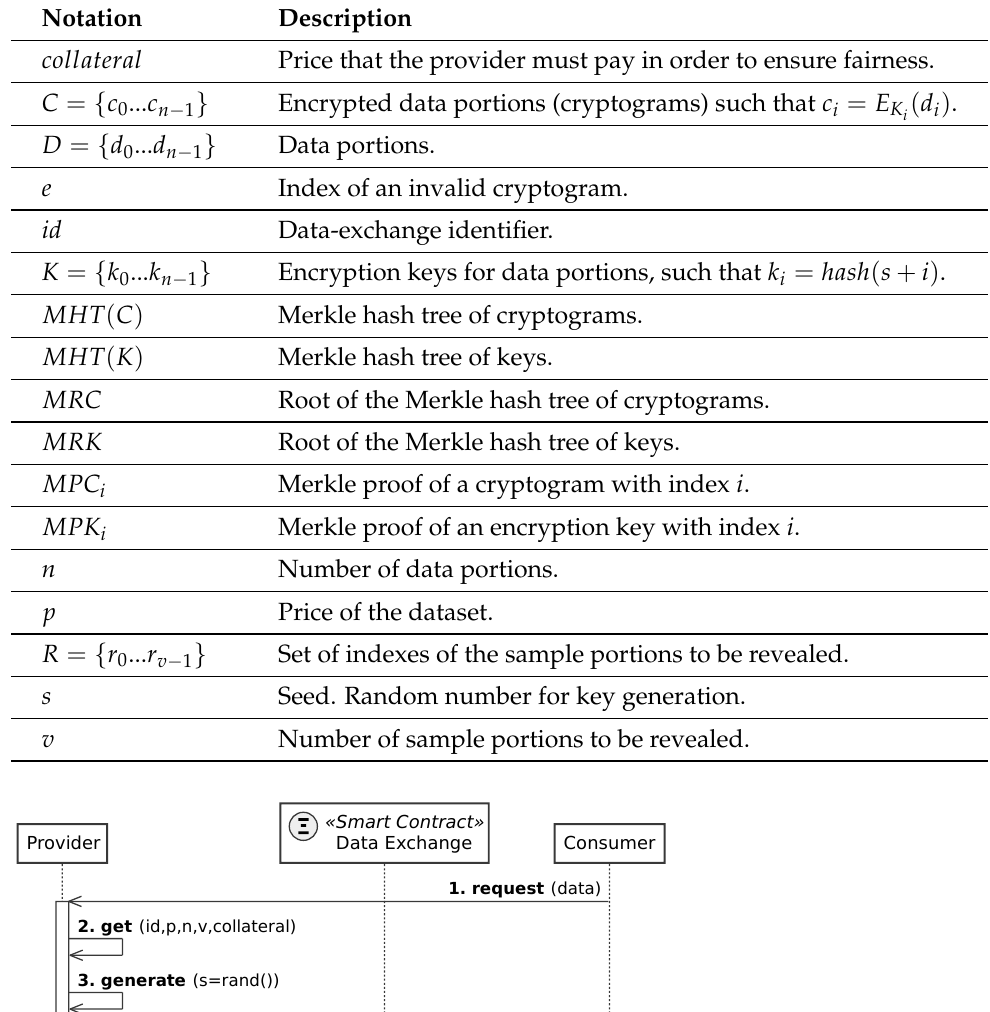
Table 1. Notation for the DEFS protocol.